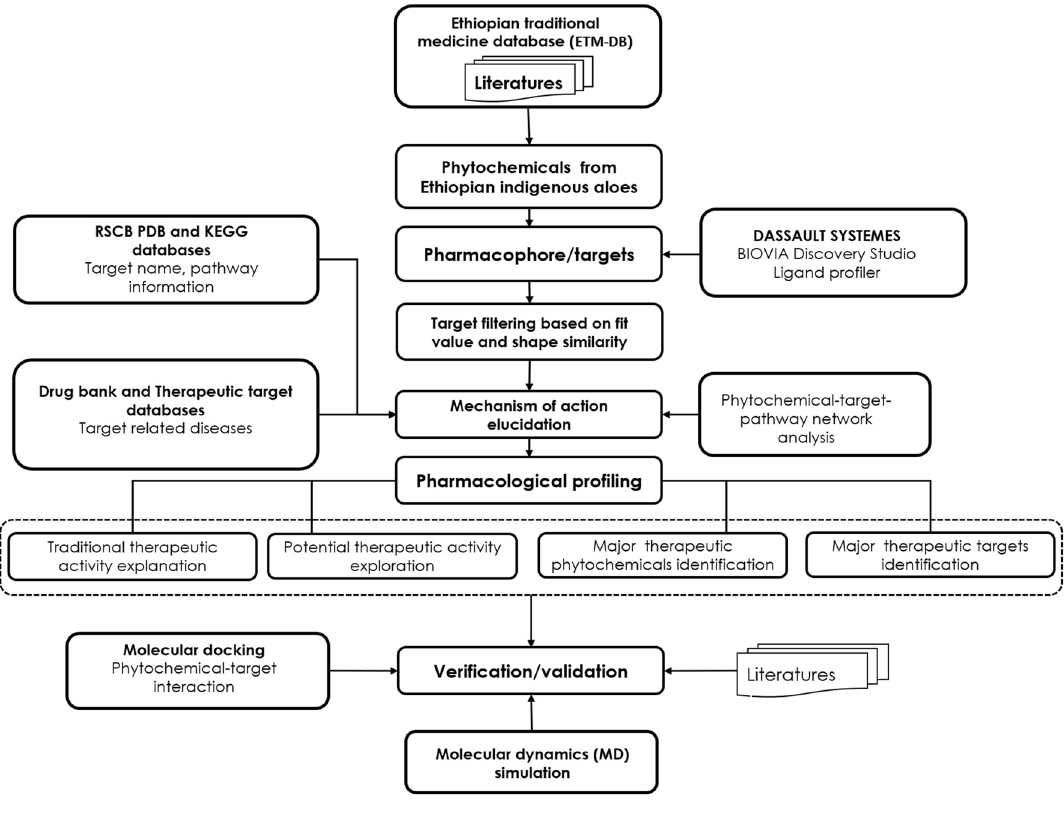
Figure 10. The workflow used in this